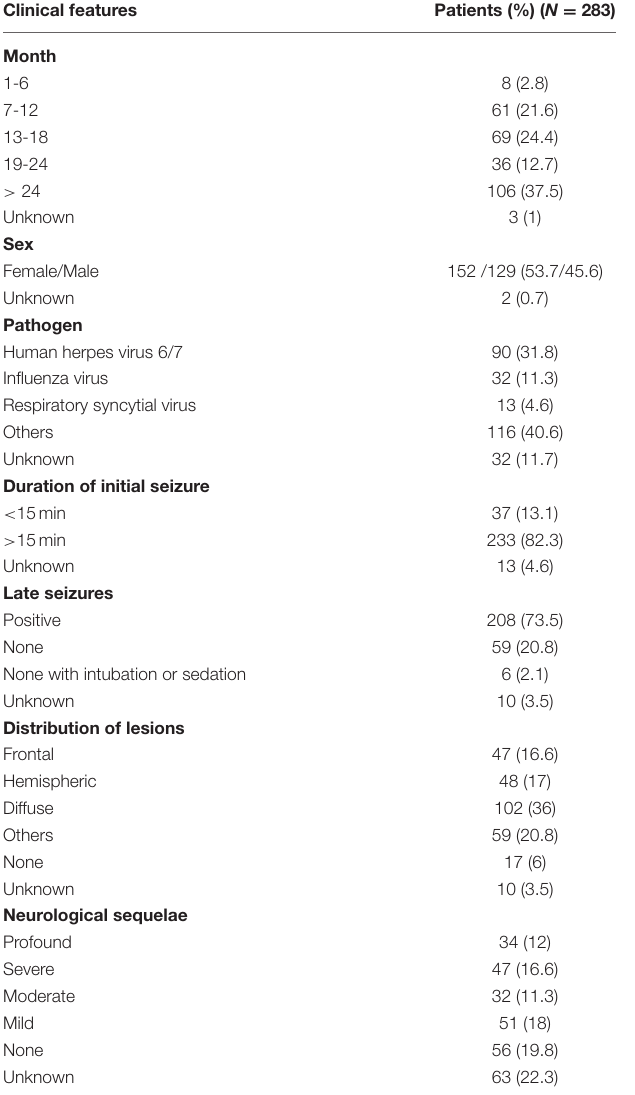
TABLE 2 | Clinical characteristics of the patients. TABLE 3 | Case-control association study of rs16944 in acute encephalopathy with biphasic seizures and late reduced diffusion